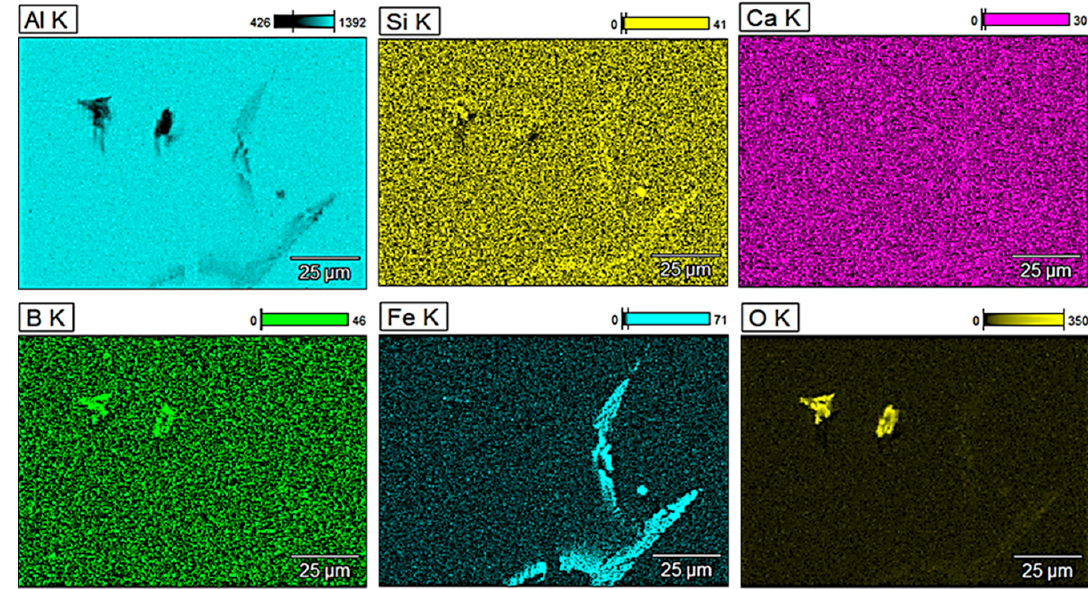
Figure 5. EDX mapping of EN AW 1370 with 2 wt.% of GF reinforcement (metallurgical synthesis).